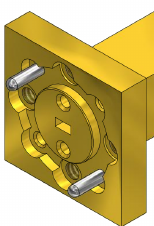
Figure 1. VDI waveguide flange [18].